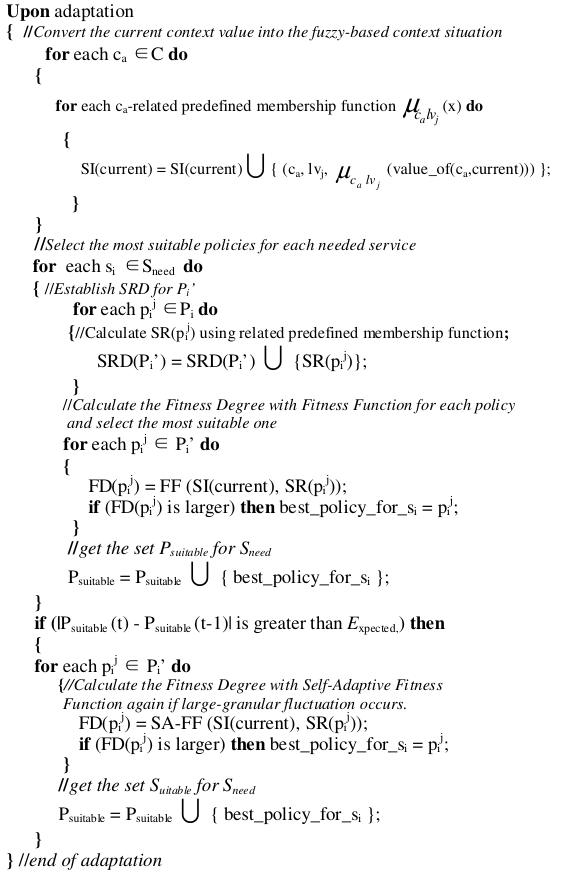
Fig. 6. The SA-FSAM algorithm Step 1 , each context is fuzzified into a linguistic variable with associated linguistic values. All the values are composed as Context Situation. Step 2 , the Context Situation and a membership degree determined by predefined membership at time interval t , i.e. SI(t), is substituted into the Fitness Function to calculate the fitness degrees corresponding to each policy. Step 3 , after all fitness degrees are compared, the policy with the largest fitness degree is specified as the most suitable policy P suitable , i.e. If FD( p ij ) is the maximum fitness degree, p ij is selected as the most suitable policy P suitable